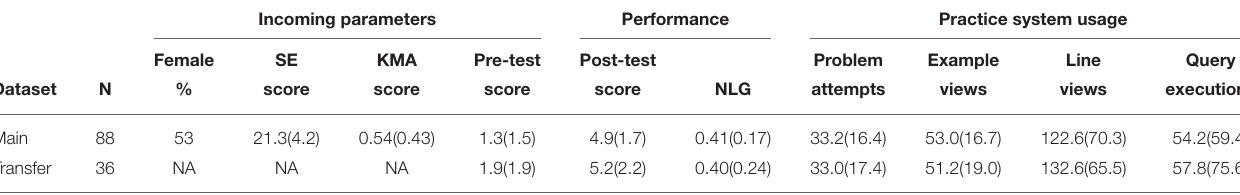
TABLE 1 | Summary statistics of the main and transfer